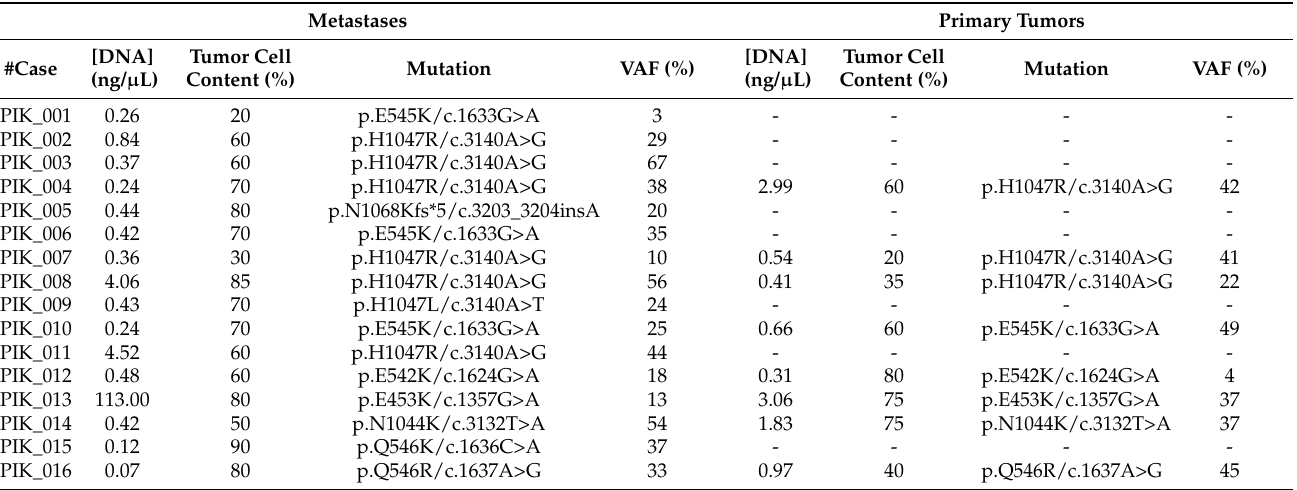
Table 3. Summary of the PIK3CA mutations detected using NGS on primary tumor and metastasis samples. Mutations are annotated according to both amino acid change and coding. VAF, variant allele frequency; NGS, next-generation sequencing.